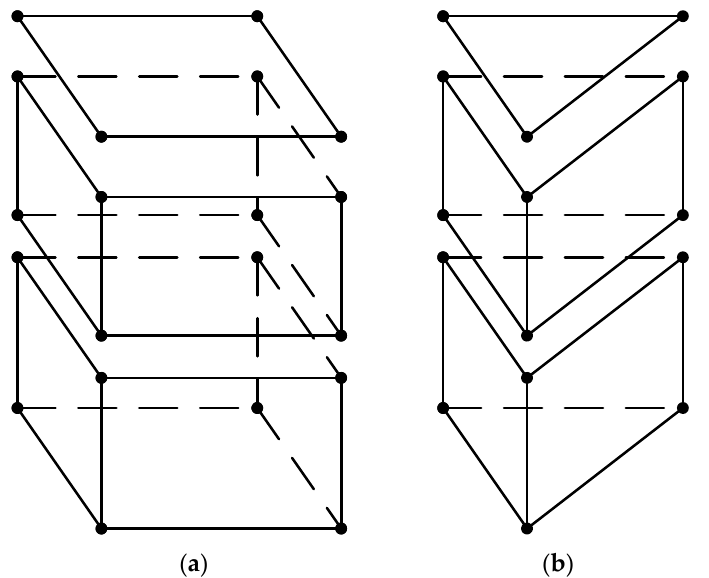
Figure 1. Schematic view of a column of three-dimensional computational elements. ( a ) quadrangular prisms; ( b ) triangular prisms.